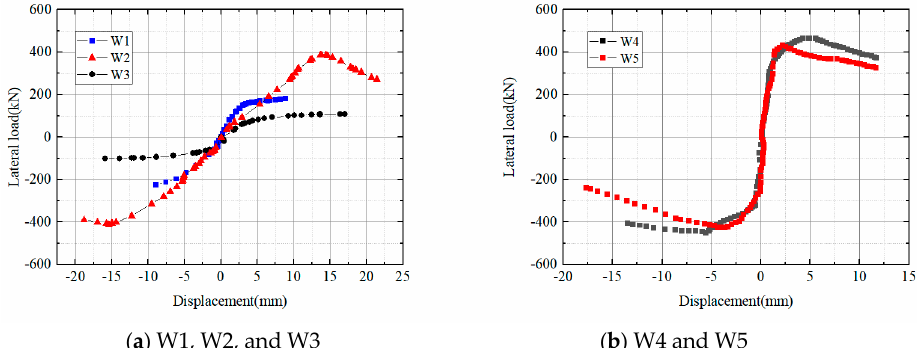
Figure 10. Skeleton curves of specimens: ( a ) W1, W2, and W3; ( b ) W4 and W5.